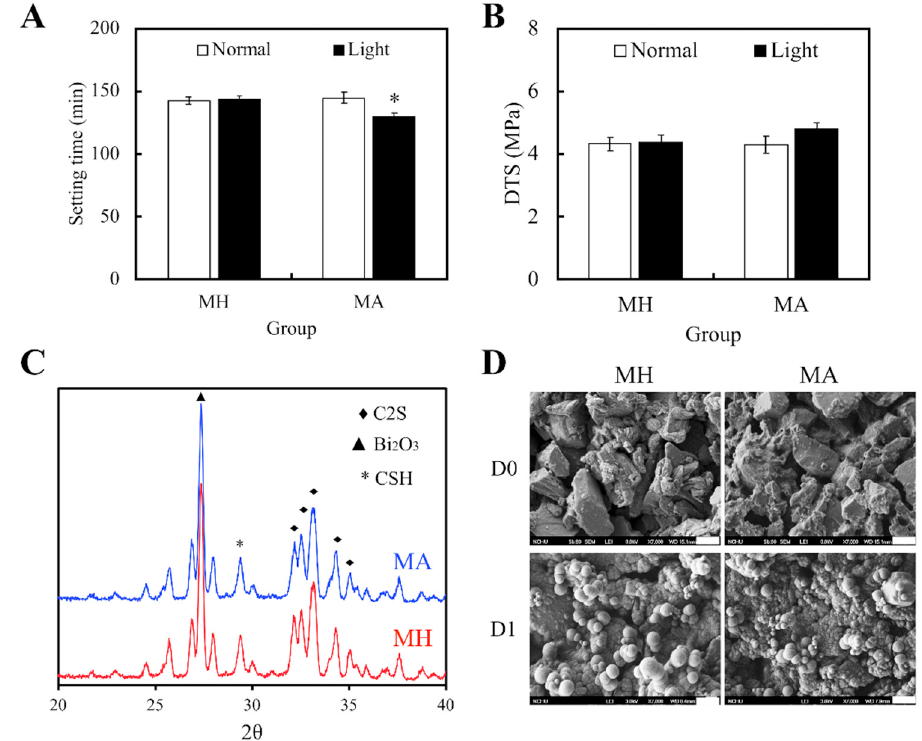
Figure 1. ( A ) Setting durations and ( B ) diametral tensile strength of Mineral Trioxide Aggregate (MTA) cements after Aminolevulinic acid (ALA) augmentation and light treatment. Statistical data are displayed as means ± standard deviations for n = 6. “*”, and the results exhibit statistically great differences ( p < 0.05) in comparison to non-red light treated MTA. ( C ) X-ray diffraction (XRD) of MTA, with and without ALA, after a day of hydration at 37 °C. ( D ) SEM images of the surface of MTA-ALA scaffolds on day 0 and day 1 of simulated body fluid (SBF) immersion.